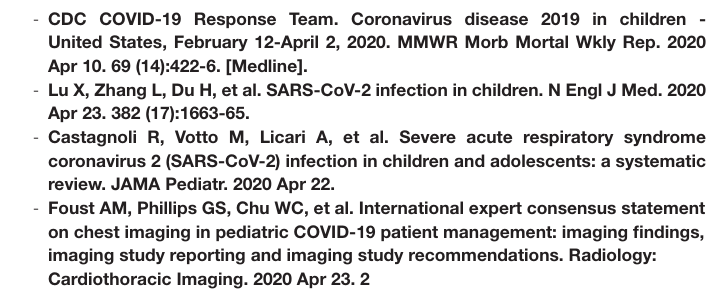
TABLE 14 | COVID 19 manifestations in paediatric. Manifestations